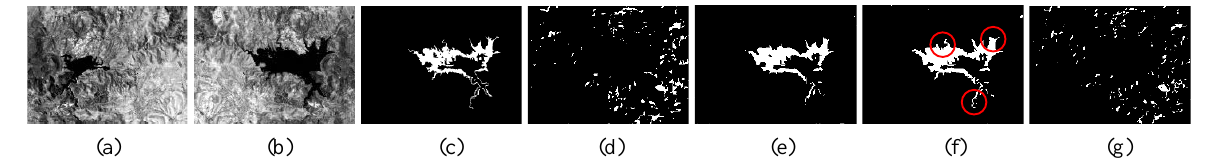
Figure 7. Visualized change detection results for different pre-trained networks on the optical Muragia dataset. (a) Image captured at